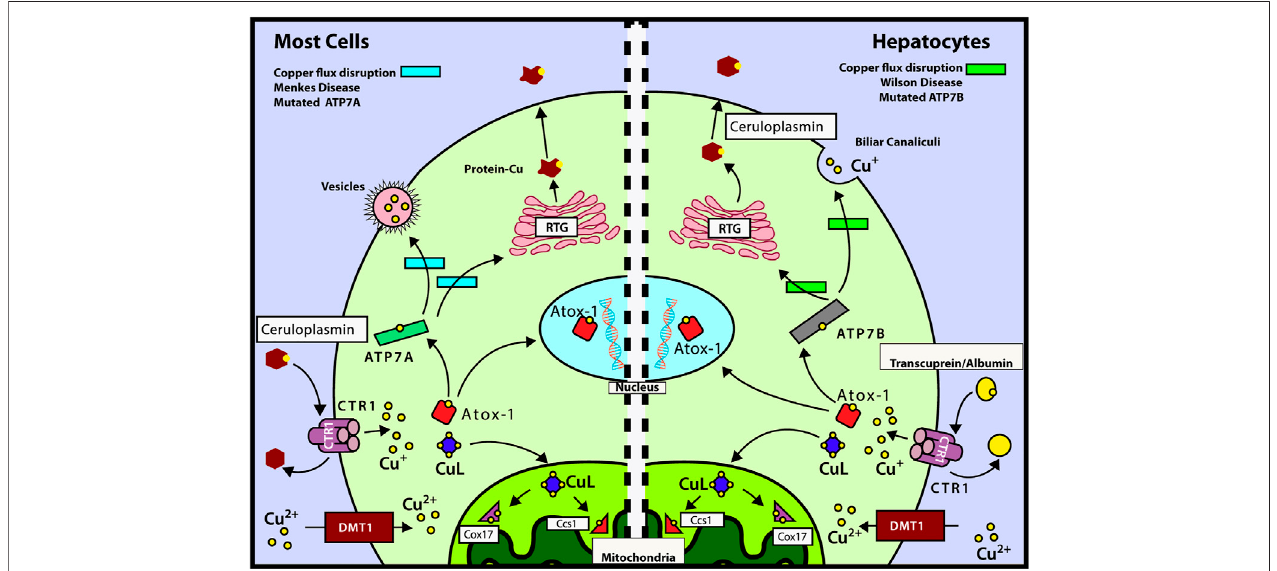
FIGURE1| Mechanismsofintracellularcoppertransport.AfterCuisdeliveredtoCTR1 bytranscuprein/albumin/ceruloplasmin,itistranslocated tocytosol,where it can be transferred either to mitochondria by copper ligand CuL or incorporated into ATOX1. ATOX1 can translocate into nucleus, by a copper-mediated mechanism, and deliver its copper to ATP7A/B. Left panel: mechanisms of copper transport for most cells (except hepatocytes). ATOX1 delivers Cu to ATP7A which in turn transports it to the TGN or transfers it into vesicles to be excreted out of the cell. During copper de fi ciency and excess, metallothioneins MT-I and MT-II regulate ATP7Atraf fi ckingandcontrolcellviability(Gudekaretal.,2020). Right panel:mechanismsofcoppertransportforhepatocytes.ATOX1donatescoppertoATP7Bwhich transports it to the trans-Golgi network (TGN) for incorporation into ceruloplasmin. ATP7B is also responsible for the transport of Cu to the cellular periphery to be incorporatedintothebile(main incharge ofcopper excretion). Also,wecanobservetheroutesaffectedbythediseasesofWilsonandMenkesinthegreenand lightblue rectangles,respectively.Modi fi edfromthestudybyFischerand Goode(1994),Puig andThiele (2002),Cobineet al.(2006a),Cobineet al.(2006b), andQinet